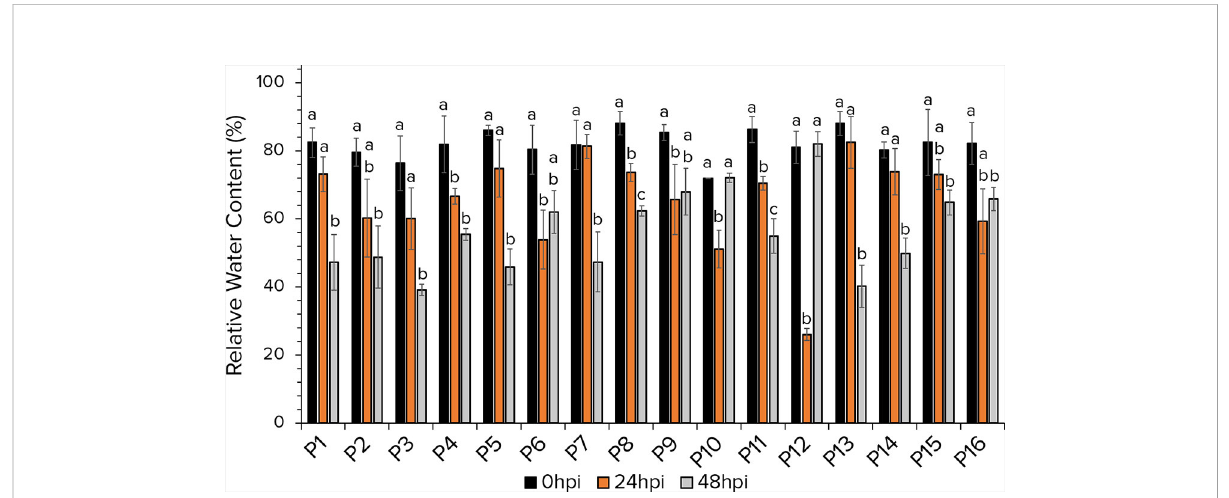
FIGURE 4 The leaf Relative Water Content of 16 lentil accessions at 0hpi, 24hpi and 48hpi with aphids. For each accession, estimates at different timepoints that share no common letter are statistically signi fi cant according to Tukey ’ s HSD ( p <0.05).